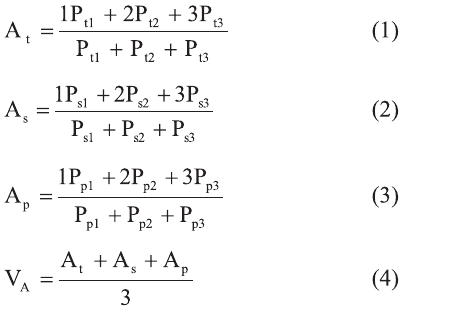
Fig. 2. SEM microphotographs of well-preserved Echinocyamus pusillus Müller, 1776 (sample GPIT/EC/00740) from Giglio Island, Recent. A . Specimen gg-al-1.11, in aboral view, showing petalodium including paired ambulacral pores (A 1 ); well preserved surface detail of the aboral surface with sunken tu- bercles, glassy tubercles, and paired ambulacral pores (A 2 ). B . Specimen gg-3t-3.60, in oral view, showing central peristome, periproct situated half way be- tween peristome and the posterior margin as well as a drillhole at the upper left (B 1 ); well preserved predatory drillhole with internal support still preserved within the skeleton (B 2 ). C . Specimen gg-na-1.1, well preserved peristome on the oral surface, showing tubercles and secondary unipores. D . Specimen gg-pm-4.35, very well preserved tubercle showing differential stereom densities of the perforated mamelon, crenulated boss, and sunken areole.